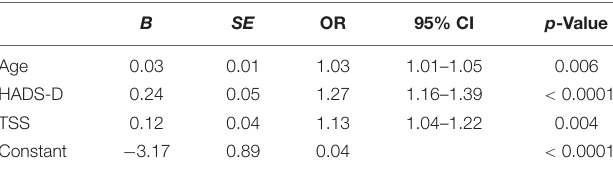
TABLE 4A | Multivariate binary logistic regression model of factors predicting altered sleep quality in FD patients. B